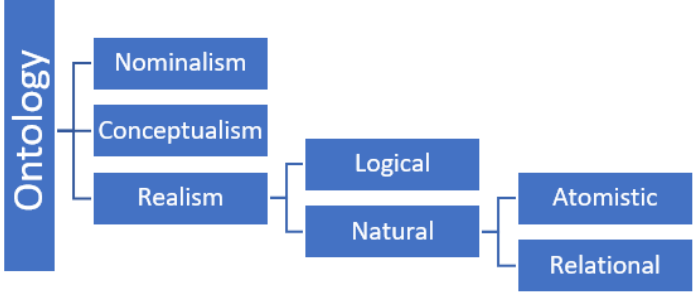
Figure 2. Scheme of the main ontologies in the Western tradition.